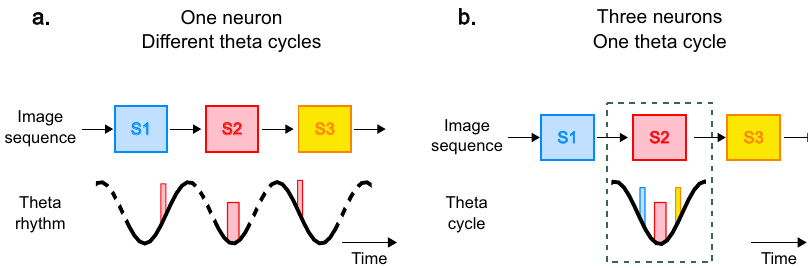
Fig. 5 Summary of main results. A A participant views a sequence of three images (S1 to S3). A neuron whose preferred stimulus is S2 fi res at the trough of the oscillation during the presentation of S2 (~180°; see Fig. 3B). S1 and S3 are the preceding and following stimuli for this neuron and it fi res at phases ~230° and ~120° when S1 and S3 are presented, respectively (Fig. 3B). The thickness of the bars represents the fi ring rate. The stippled lines for the theta rhythm indicate that the theta cycles are not necessarily consecutive. B While stimulus S2 is the preferred stimulus for one neuron, it is also the following stimulus for the neuron selective to S1, and the preceding stimulus for the neuron selective to S3. When S2 is presented on the screen, the neuron whose preferred stimulus is S2 fi res around the trough of the oscillation. The neuron whose preferred stimulus is S1 (in blue) will fi re at ~120° (S2 is the following stimulus for this neuron). Finally, the neuron whose preferred stimulus is S3 (in yellow) will fi re at ~230° (S2 is the preceding stimulus for this neuron). Thus, in a given theta cycle, successive items are represented in the same order as the temporal order of the